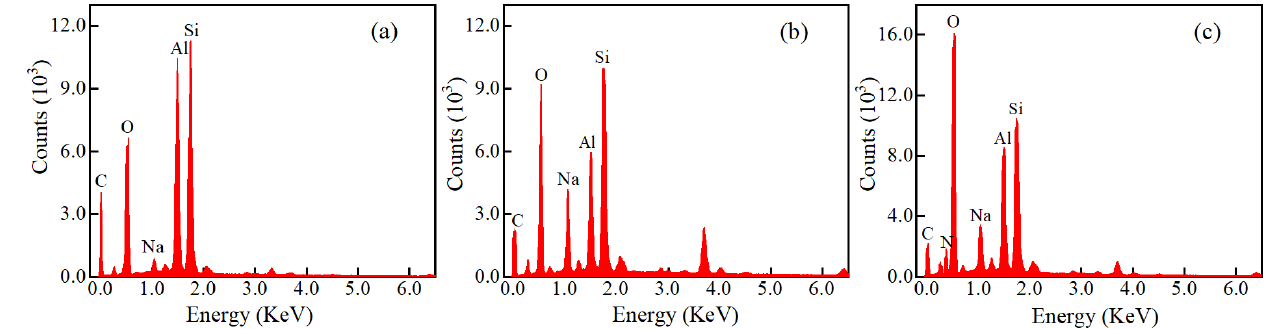
Figure 4. Energy spectra of ( a ) CFA; ( b ) NaOH ‐ CFA; and ( c ) NaOH ‐ CFA adsorbing ammonia nitro ‐ gen.